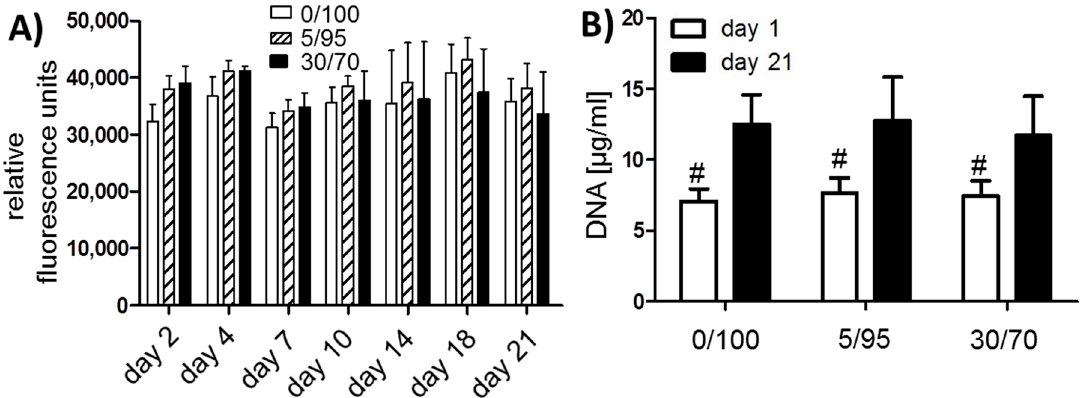
Figure 2. Cont . Figure 2. Cont .